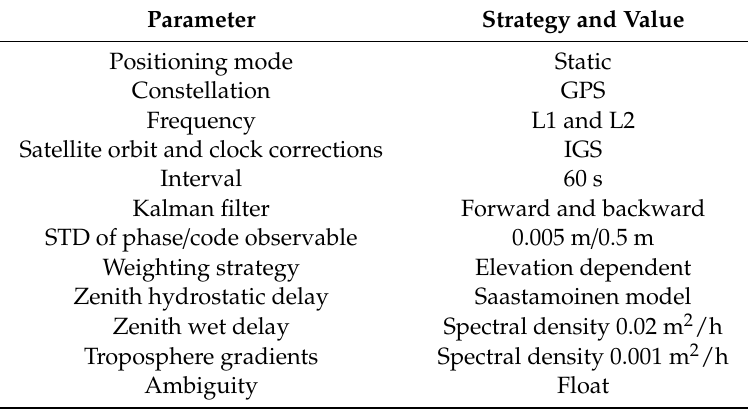
Table 1. Summary of the strategy of data processing.